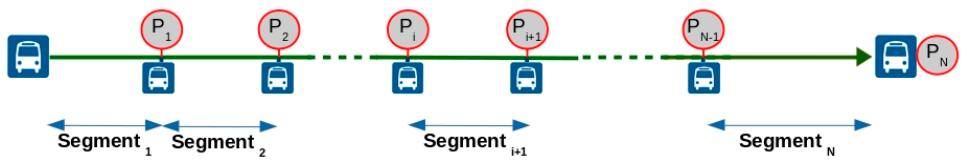
Figure 2. Schematic representation of a line according to the